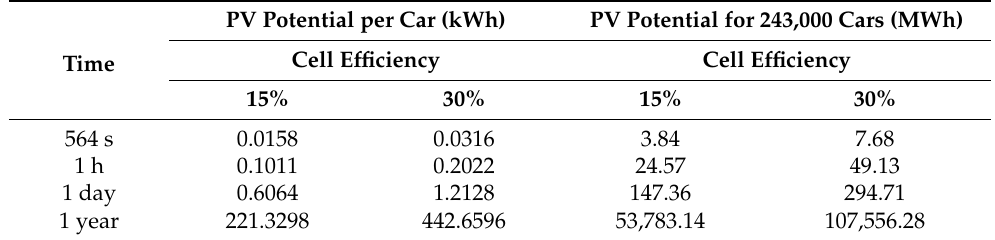
Table 4. Estimation of PV potential from PV-powered EV based on a hypothetical scenario. PV Potential per Car Time